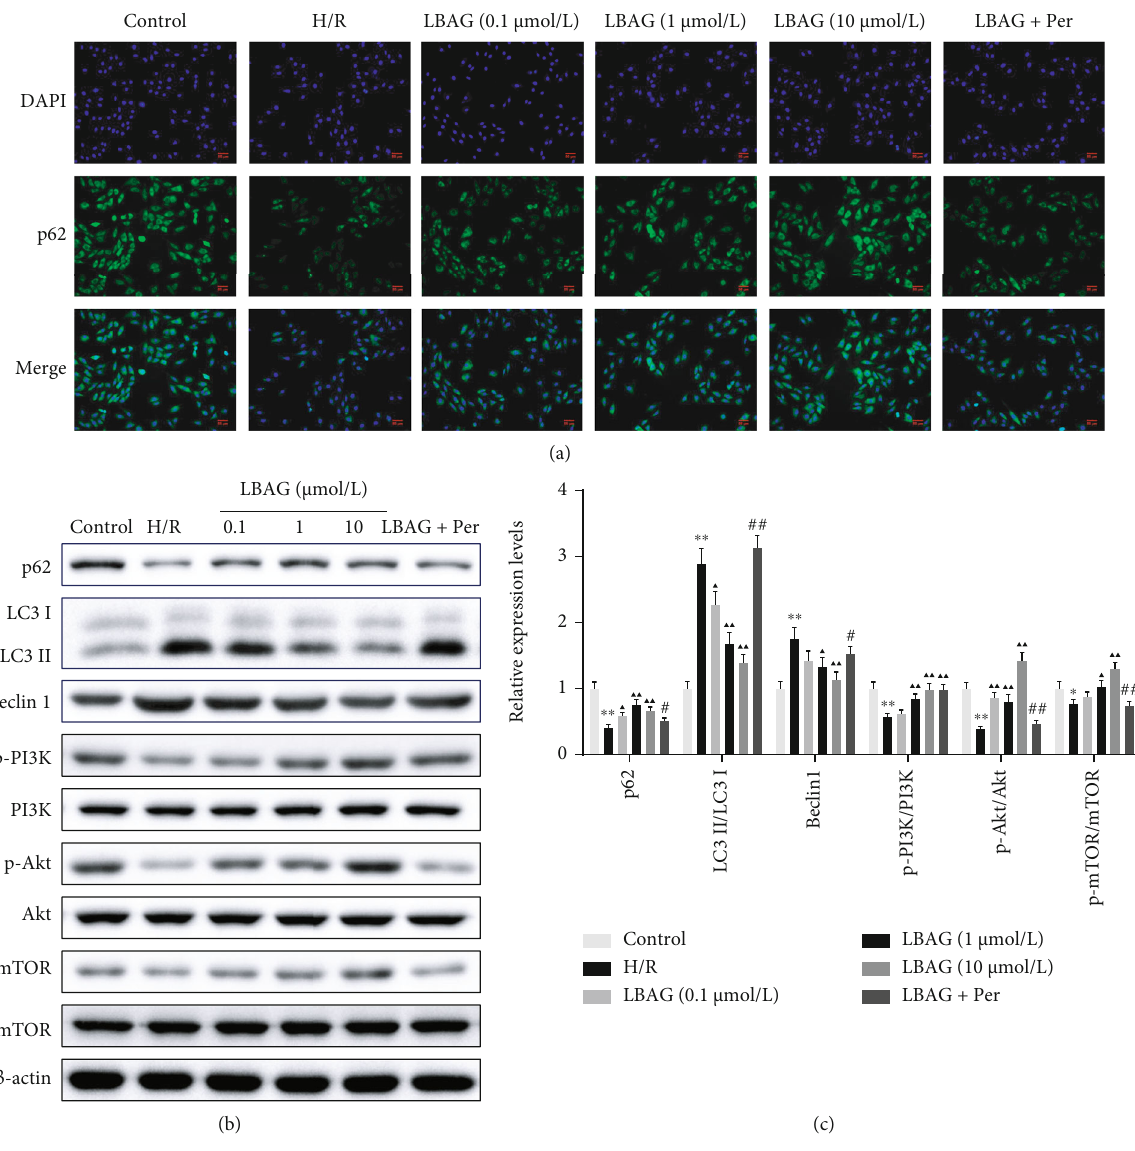
Figure 8: E ff ect of LBAG on the expression of autophagy and PI3K/AKT pathway-related proteins in H9c2 cells with H/R injury. (a) p62 expression was detected by immuno fl uorescence analysis in LBAG-treated H/R-injured H9c2 cells. Scale bar: 50 μ m. (b, c) p62, LC3, Beclin 1, and PI3K/AKT pathway-related protein levels were estimated with western blotting in LBAG-treated H/R-injured H9c2 cells. ∗ P < 0 : 05 and ∗∗ P < 0 : 01 vs. control group. ▲ P < 0 : 05 and ▲▲ P < 0 : 01 vs. H/R group. # P < 0 : 05 and ## P < 0 : 01 vs. 10 μ mol/L LBAG